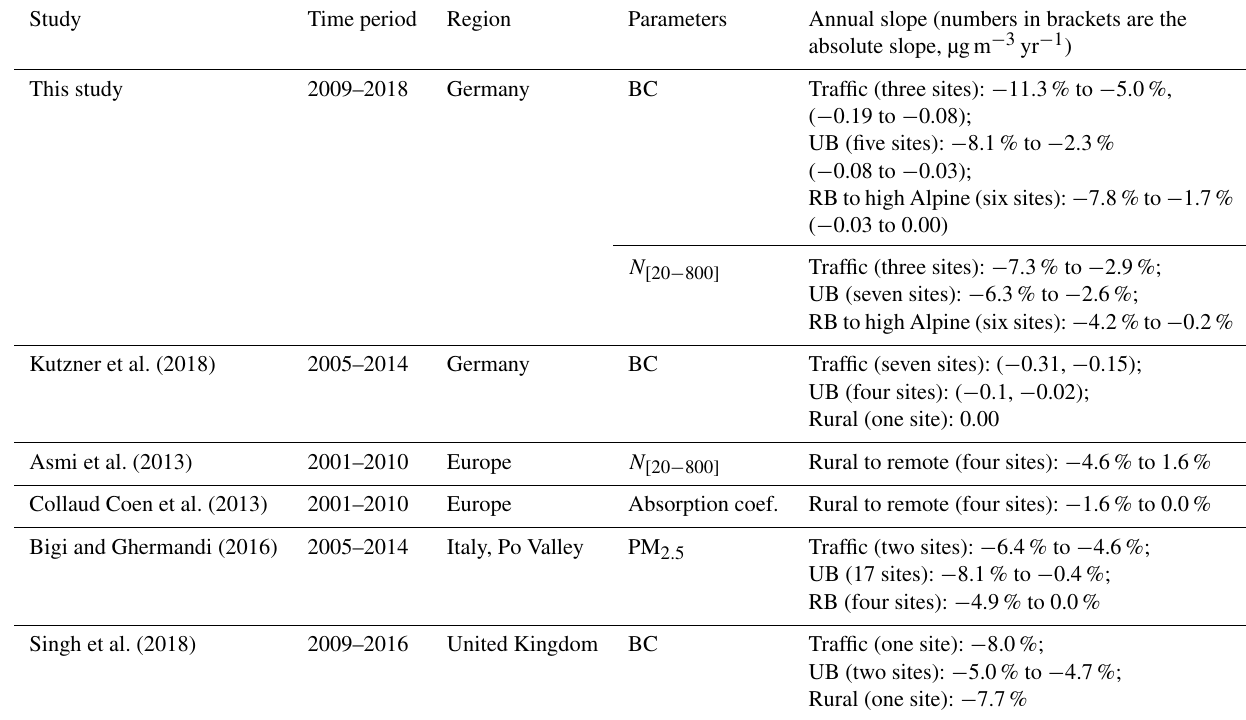
Table 4. Comparison of long-term trend studies of BC, PNC, and PM in Europe.